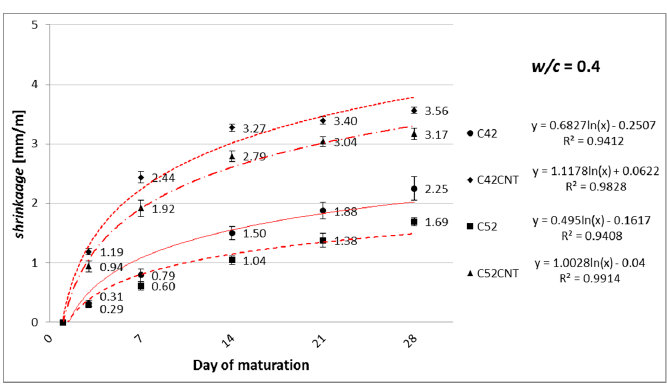
Figure 5. Increase in linear shrinkage of modified cement paste with w / c = 0.4, as a function of maturation time.